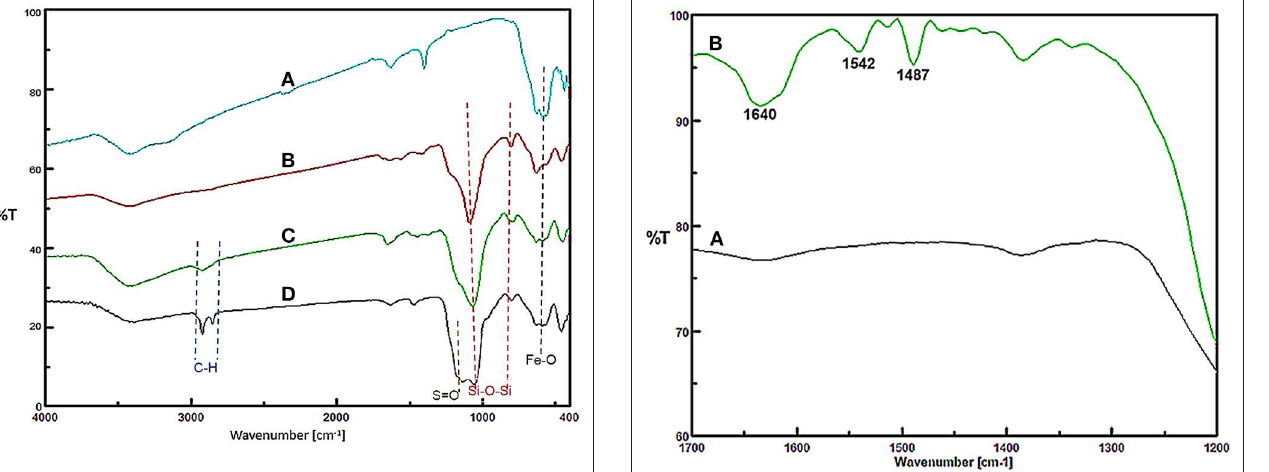
The magnetic properties of Fe 3 O 4 , Fe 3 O 4 @SiO 2 , Fe 3 O 4